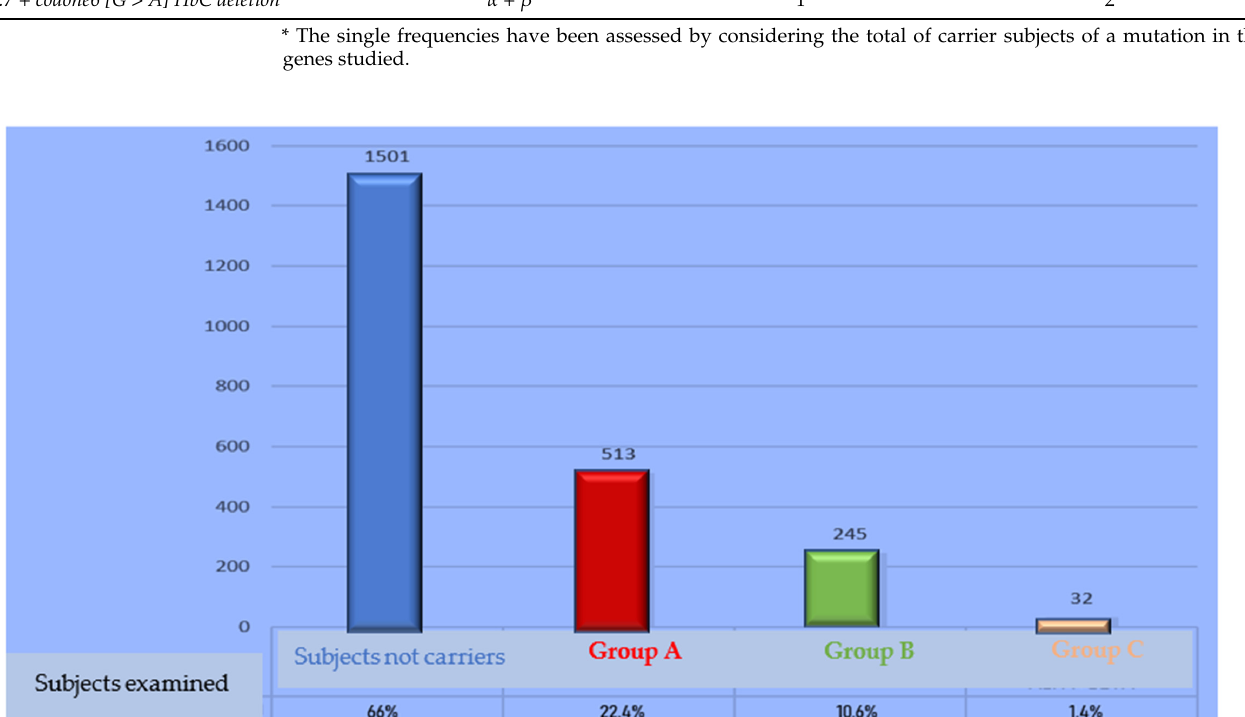
Figure 2. Populations grouped in carriers or not and for mutations showed. The study sample also included 110 (4%) (see Figure 1) foreign subjects residing in the province of Trapani. Of these subjects, 59 (54%) did not have a mutation, and 51 (46%) had a mutation in the α - or β -globin gene or both. The most frequent mutation of the α gene was the - α 3.7 deletion (51%); the most common mutation of the β gene was the A > T substitution on codon 6 with formation of the haemoglobin variant HbS (6%). The most frequent α + β genotype was determined by the deletion - α 3.7/codon 6 A > T HbS (16%). Five of the patients examined were affected by sickle cell anaemia and one subject was affected by micro-drepanocytosis, a condition characterized by compound